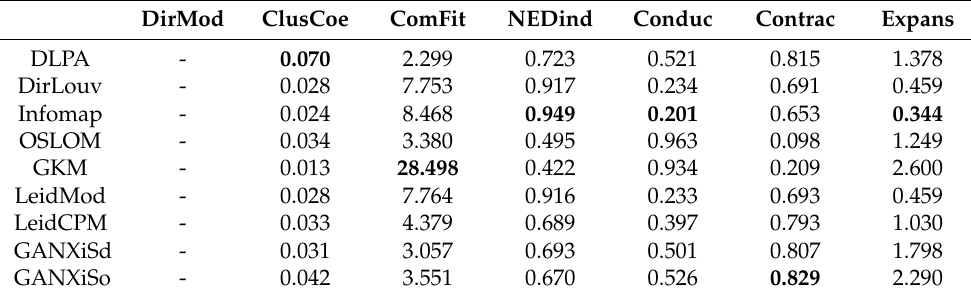
Table 3. Results of evaluations by metrics on the Cologne dataset.